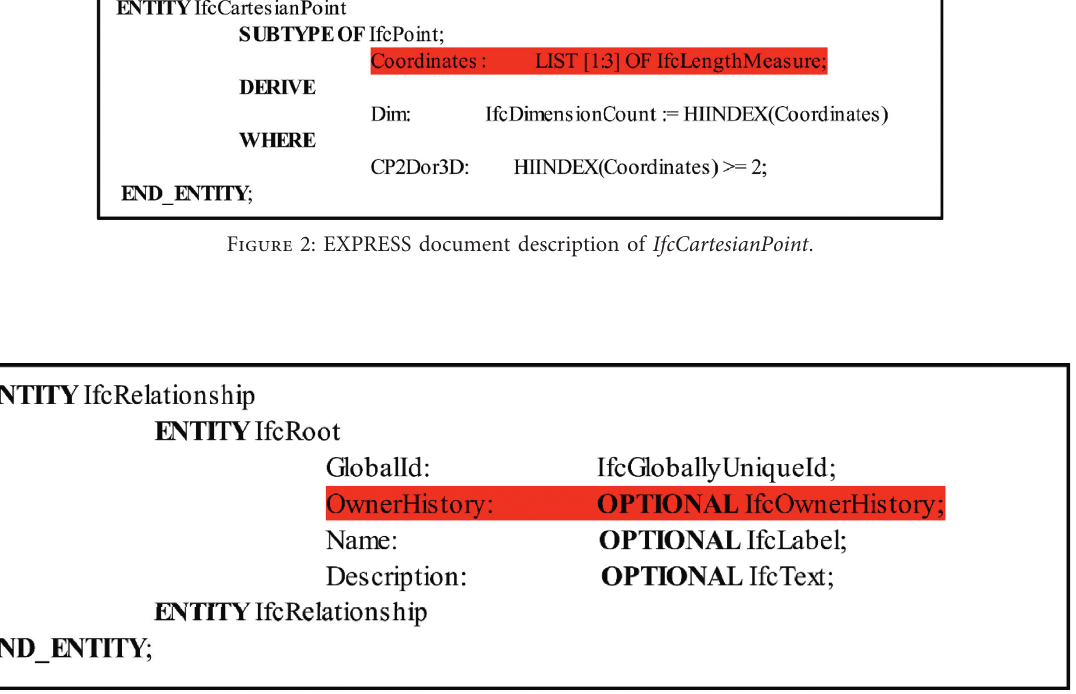
Figure 3: EXPRESS document description of IfcRelationship .